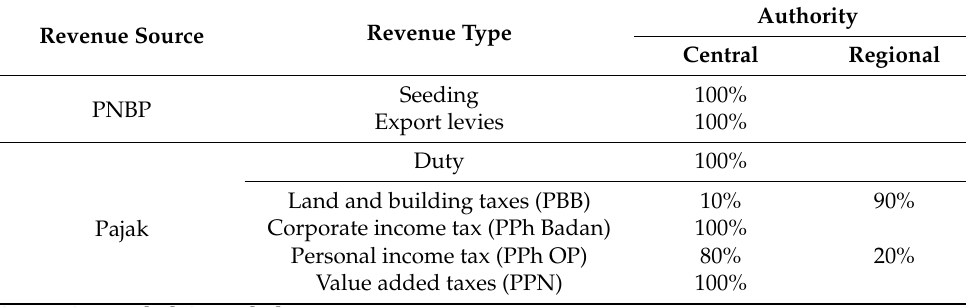
Table 2. State revenues from the oil palm